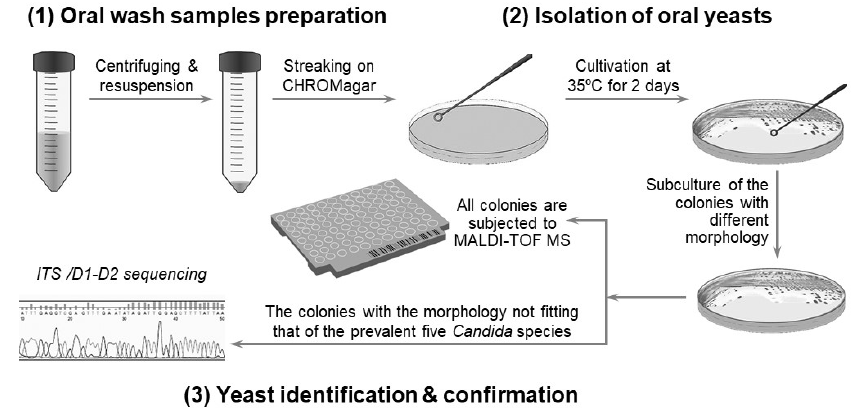
Figure 1. Scheme for the identification of oral yeast for the study. The strategy to isolate and identify yeast involves: (1) preparation of oral wash samples, (2) yeast isolation, and (3) identification and confirmation of the yeast.